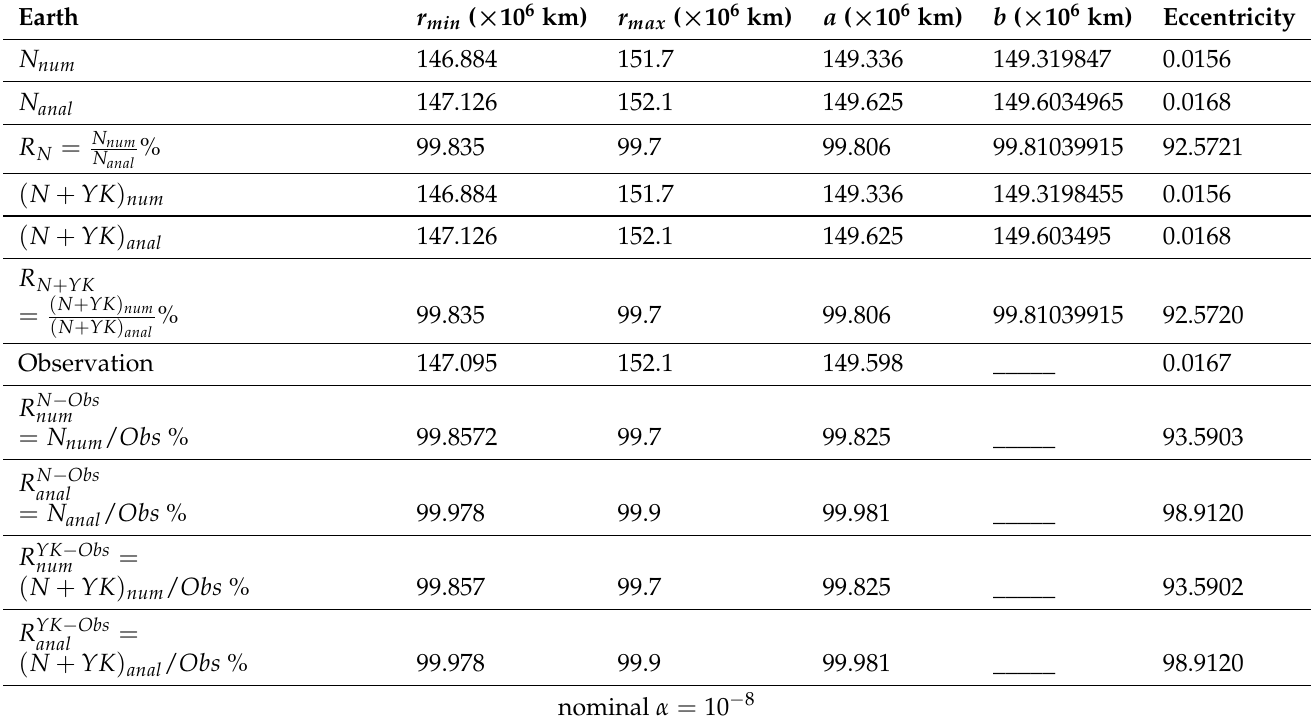
Table A5. The values of the calculated and observational astronomical parameters, for nominal α , of the planet Earth, whose number of moons is